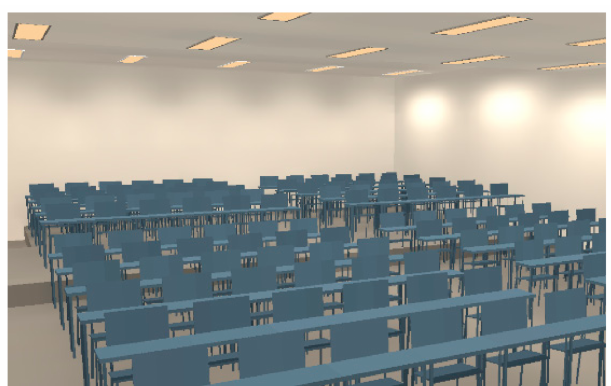
Figure 7. Actual photo of TR-214 classroom.